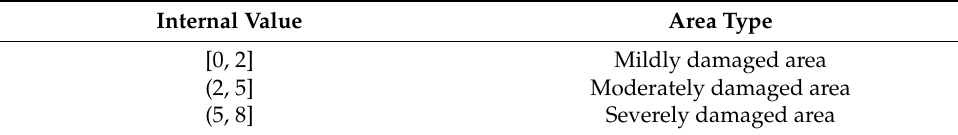
Table 7. Area division according to area